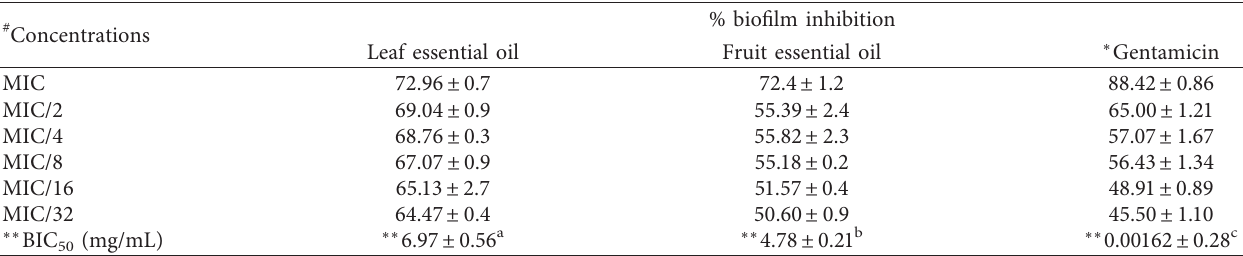
Table 5: Inhibition of P. aeruginosa biofilm formation by of leaf and fruit essential oils of Chrysophyllum albidum .